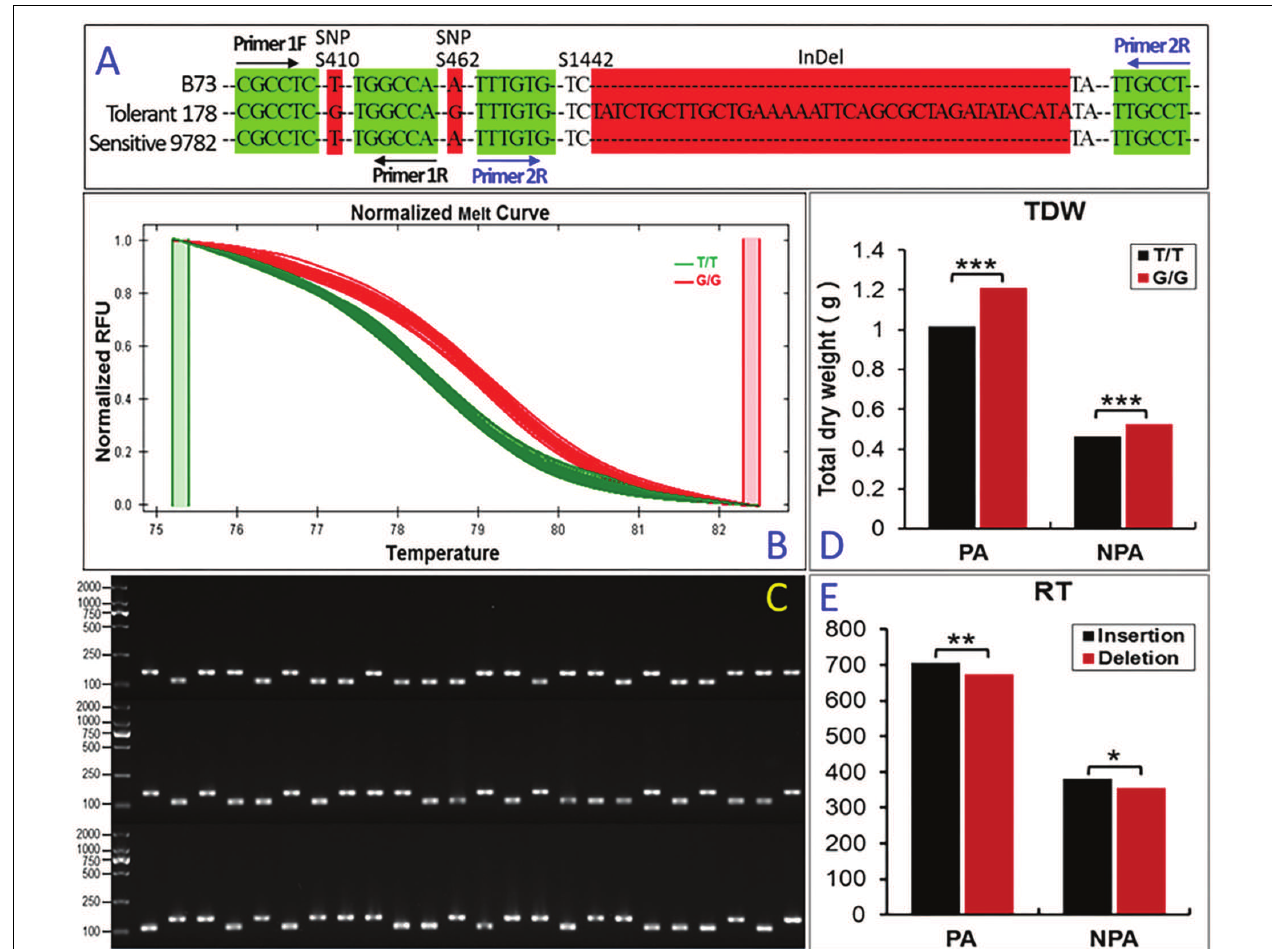
FIGURE 4 | The favorable allele of ZmARF31 improves maize phosphorus tolerance. (A) DNA polymorphisms of three sites in ZmARF31 among B73, 178 and 9782. SNPs S410 and S462, and InDel S1442 that were significantly associated with phosphorus-deficiency-tolerance traits are shaded in red. The location of PCR primers used for DNA amplification of S410 and S1442 are shaded in green by arrows. (B) Normalized high-resolution melting curve to distinguish genotypes of SNP S410 in the RIL population. Green and red curves indicate allelic SNPs, T and G. (C) Length polymorphism amplicons of InDel S1442 in the RIL population. Upper and lower lanes indicate allelic sequence loci, insertion with 38 bp and deletion. (D,E) The effect of the favorable allele in S410 on TDW and the favorable allele in S1442 on RT in the RIL population. The traits of the two groups with homozygous genotypes was assessed using t -test ( ∗ P < 0.05, ∗∗ P < 0.01, ∗∗∗ P < 0.001). RIL, recombination inbred line; TDW, total dry weight; RT, root tips; PA, P-applied condition; NPA, non-P-applied